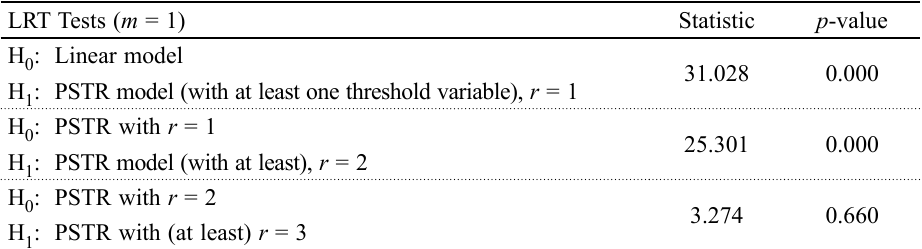
Table 8. Empirical results of the homogeneity tests for small to medium-sized banks